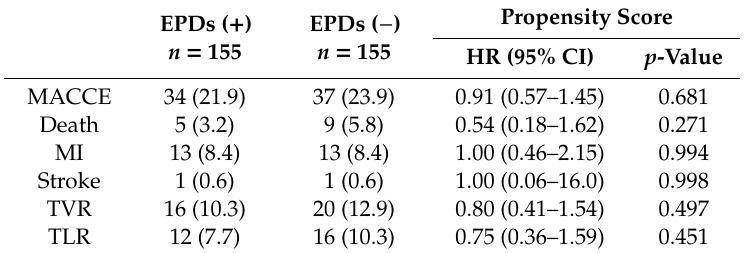
Figure 3. Kaplan–Meier Curves for death, myocardial infarction, TVR, TLR, according to the use of embolic protection devices. EPDs—embolic protection devices, MI—myocardial infarction, TLR—target lesion revascularization, TVR—target vessel revascularization. Table 4. One year follow up according to the use of embolic protection devices after propensity score matching.